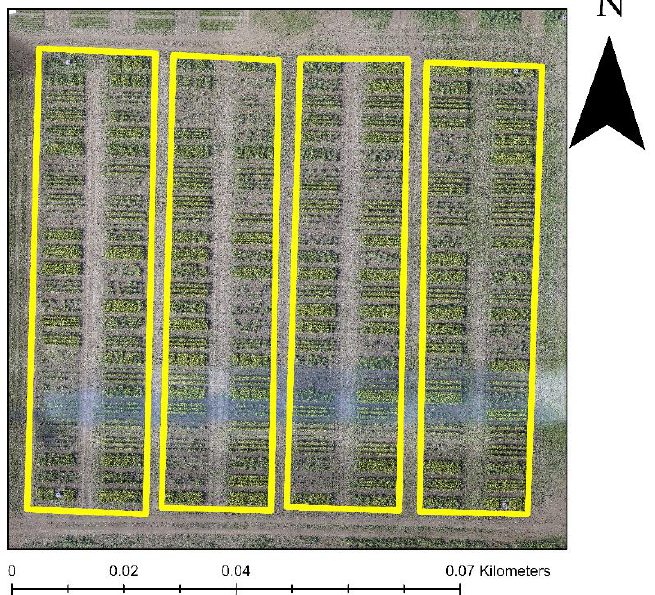
Figure 1. Experimental layout of the field trial, 2019. Forty-eight treatments were randomly dis- tributed within each block. Yellow polygons denote the four stacked replicates. tributed within each block. Yellow polygons denote the four stacked